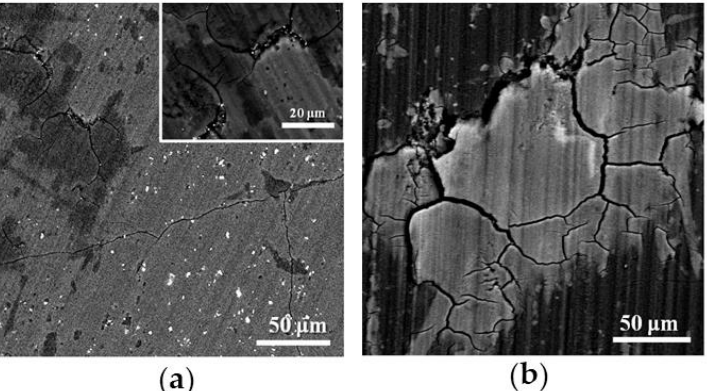
Figure 11. Backscattered electrons (BSE) micrograph of the worn surface of: ( a ) GHA50/Si 3 N 4 (higher magnification of a detail in the inset), and ( b ) GHA100/100Cr6.